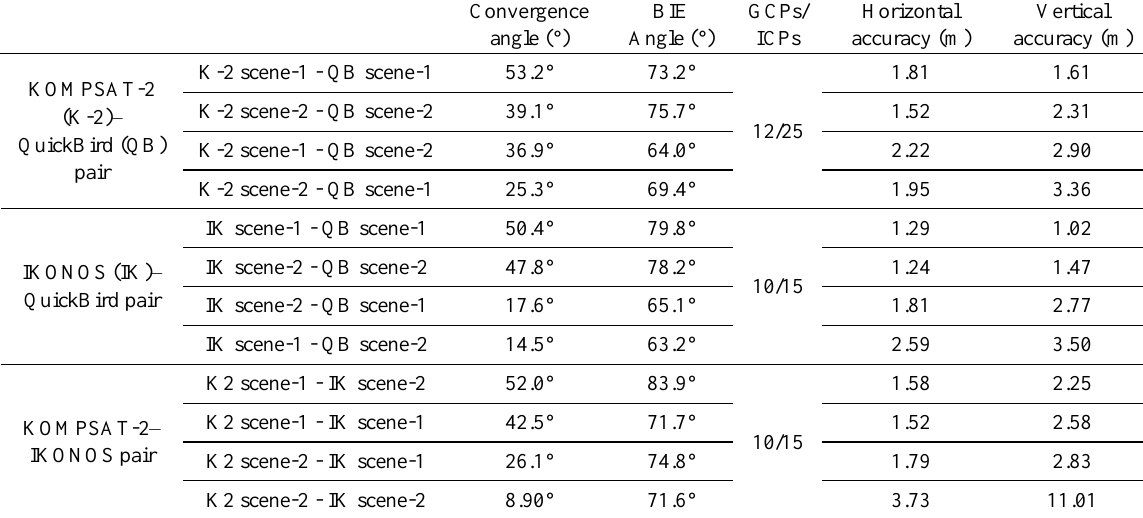
Table 3. Imaging geometry and positioning accuracy for the dual-satellite stereo